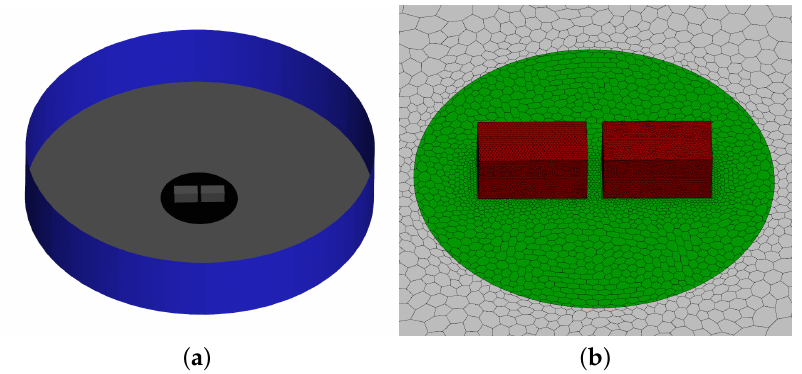
Figure 1. ( a ) Computational domain for Test Case 1 used for validation. ( b ) Computational mesh for Test Case 1 used for